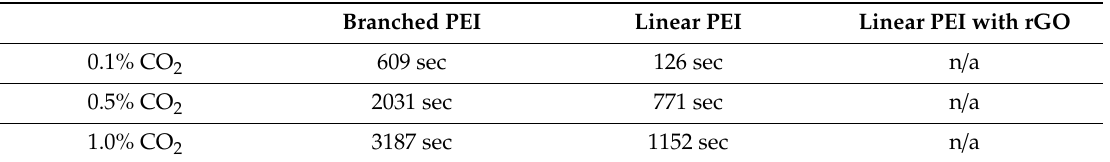
Table 4. Recovery time for each coating.